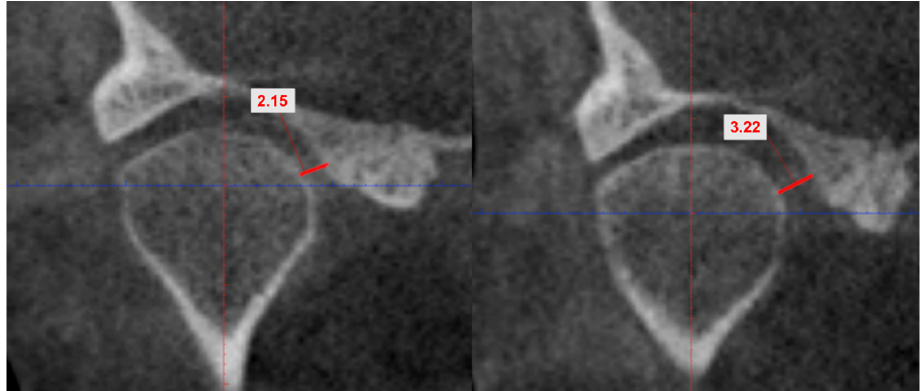
Figure 2. CBCT coronal section. The measurements of the minimal length of the medial joint space. The angle between the maximal diameter of the condyle in the axial plane and the trans ‐ verse line was used to calculate the rotation of the condyle in the axial plane (Figure 3).